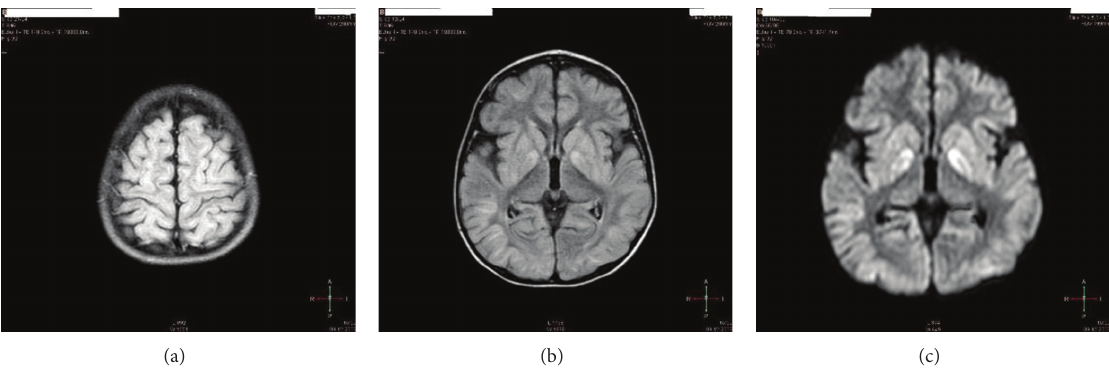
Figure 7: Brain MRI of the patient (L. B.) 2 weeks after cardiac arrest. Note, signs of severe global ischemia in cortical structures as evidenced by (a) signal hyperintensity of gyri in almost entire cortex (FLAIR sequences) and basal ganglia (b), including caudate nucleus and putamen (c) (FLAIR DWI sequences with contrast media) (see video S1, S2 in Supplementary Material [44]).